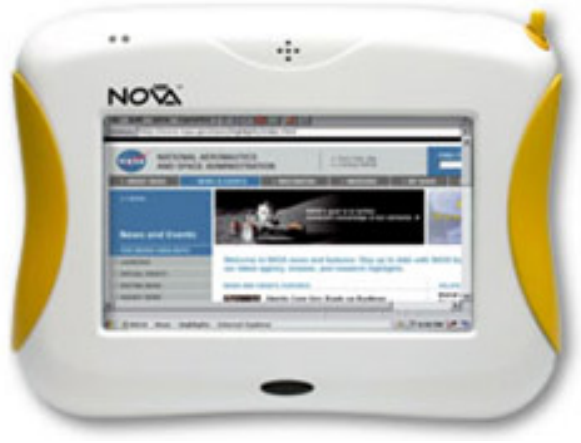
Figure 1. Ultra Mobile Personal Computer (Source: Fourier Systems http://www.fourier-